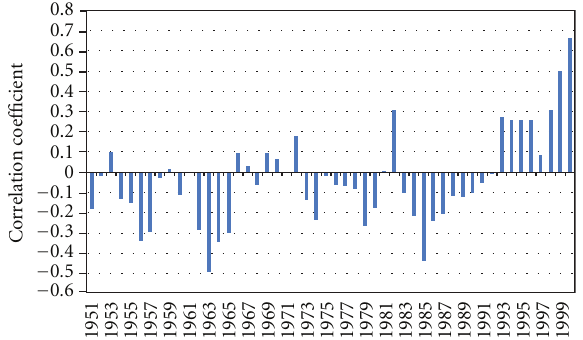
Figure 6: Ten-year running correlation between Zim SPI and PC2 for the period from 1951 to